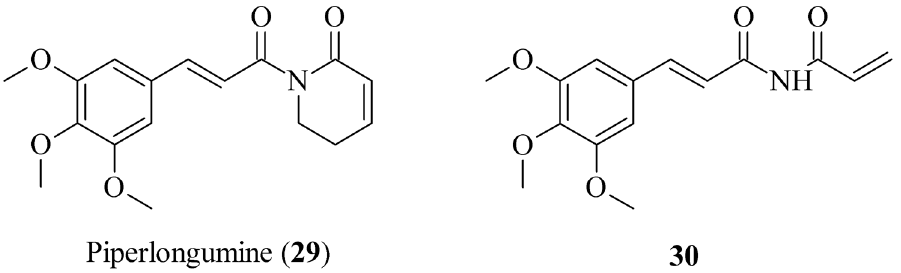
Figure 12 - Piperlongumine ( 29 ), an amide alkaloid isolated from Piper species and its biologically active simplified analogue ( 30